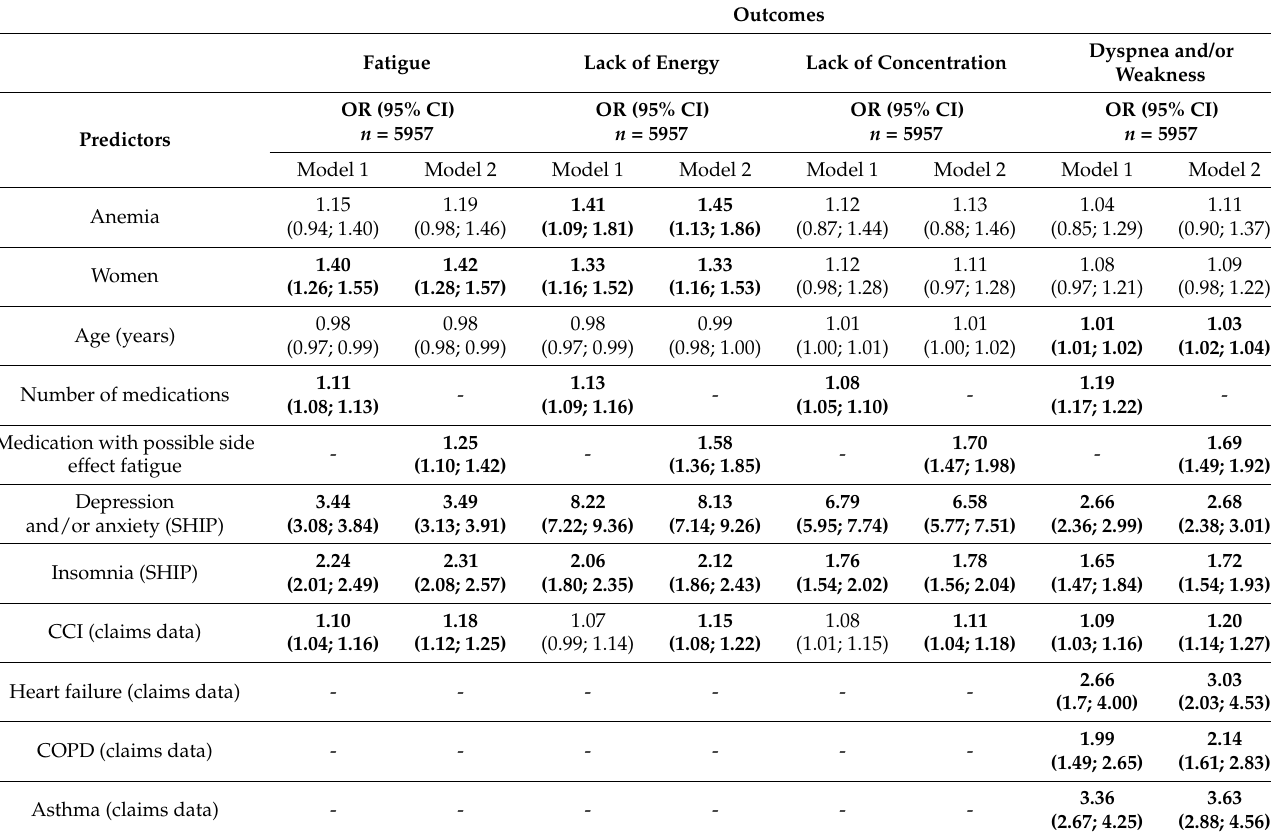
Table 5. Multivariate logistic regression models with symptoms of anemia as outcome vari- ables (weighted). Outcomes Dyspnea and/or Fatigue Lack of Energy Lack of Concentration